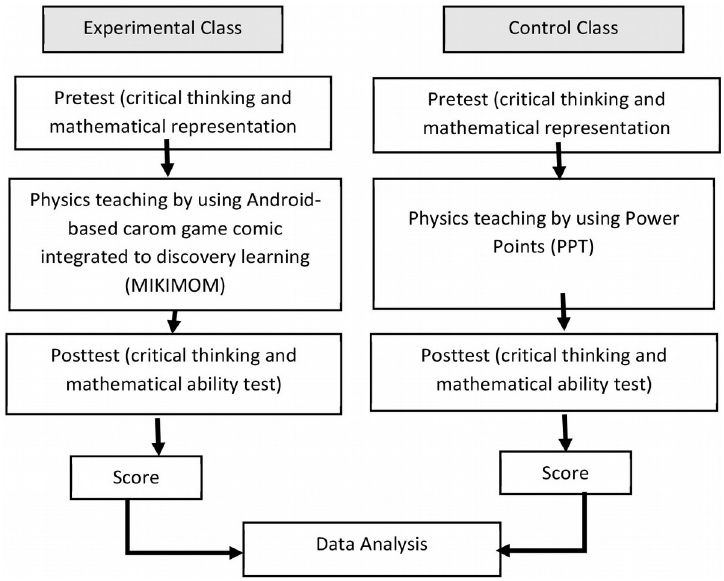
Figure 2. Research implementation